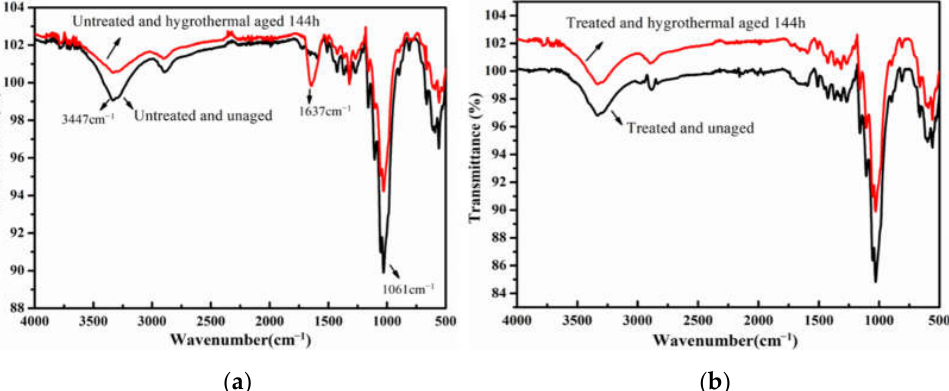
Figure 7. The IR spectra of paper-based documents before and after hygrothermal aging: untreated ( a ) and treated ( b ).